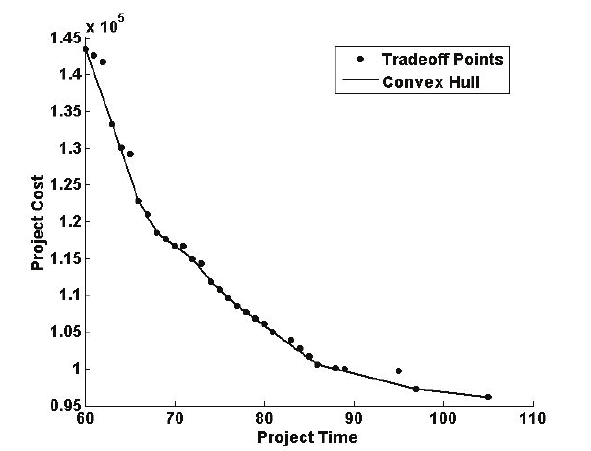
Fig. 10. ANN training of I activity of first case study